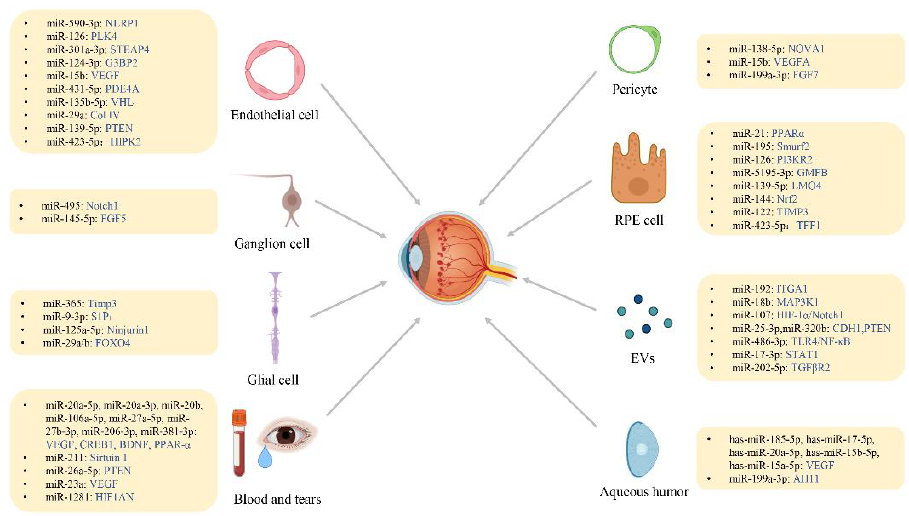
Figure 2. Schematic overview of miRNAs affecting DR-related cells and contributing to the patho- genesis of DR.